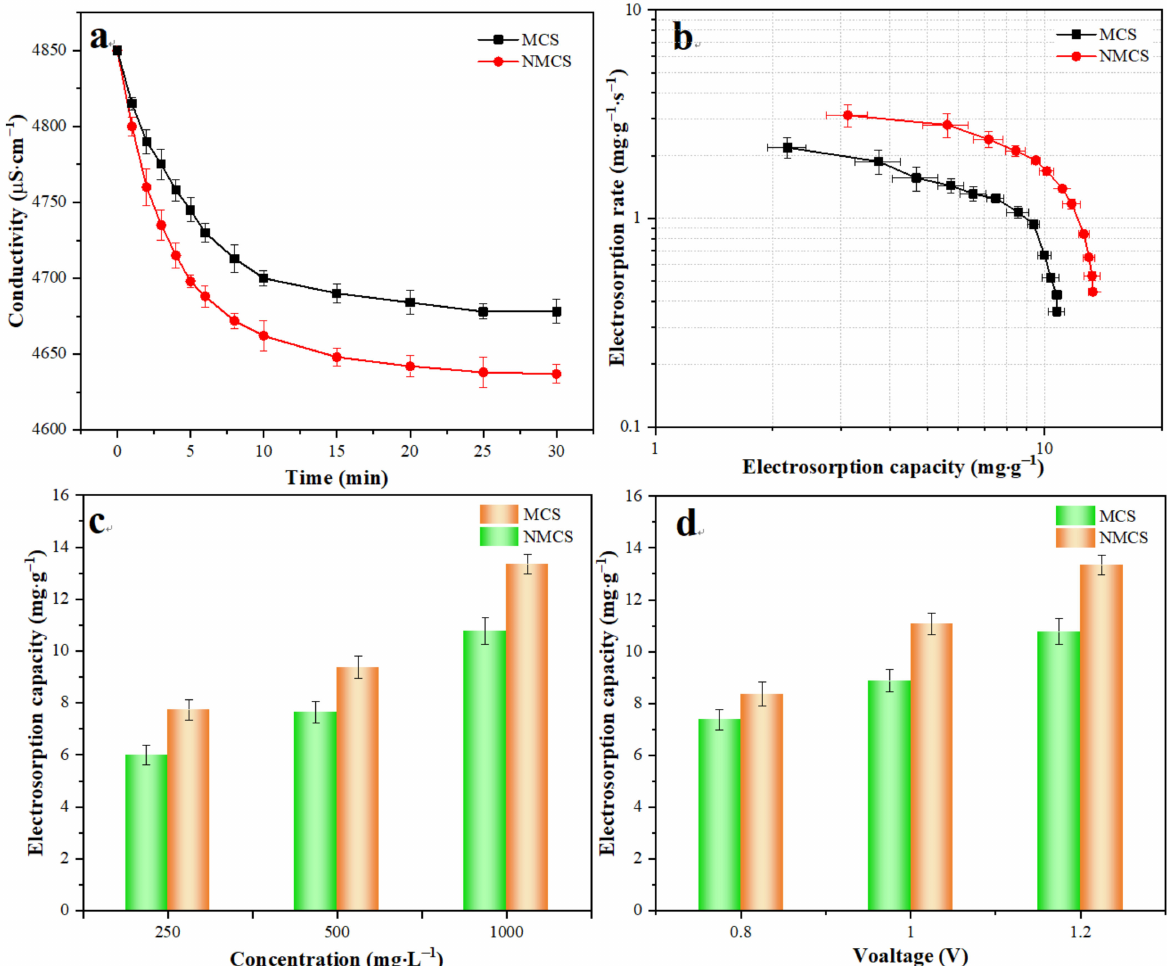
Figure 6. ( a ) Conductivity change of circulating solution of MCS and NMCS with the initial fluorine concentration of 1000 mg L − 1 at 1.2 V; ( b ) the corresponding Kim plots of MCS and NMCS with the initial fluorine concentration of 1000 mg L − 1 at 1.2 V; ( c ) electrosorption capacity of MCS and NMCS with different initial fluorine concentrations; ( d ) electrosorption capacity of MCS and NMCS with different